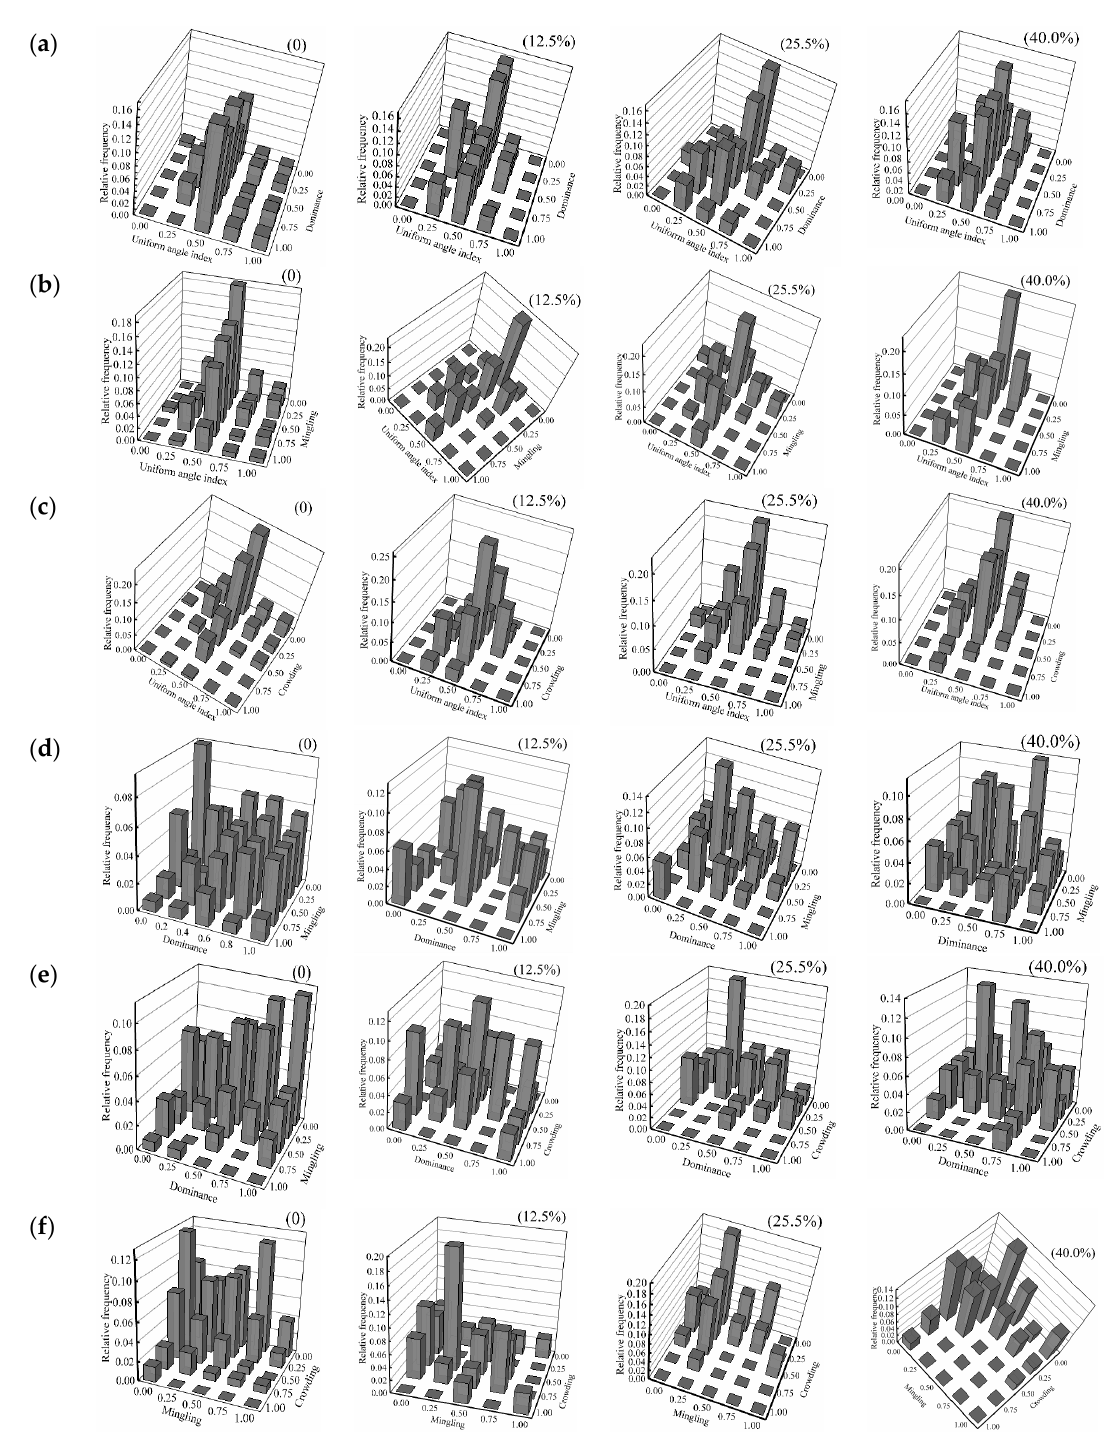
Figure 6. Bivariate distribution of the spatial structure index: ( a – f ) are the bivariate distribution of W - U , W - M , W - C , U - M , U - C , and M - C in the plots.